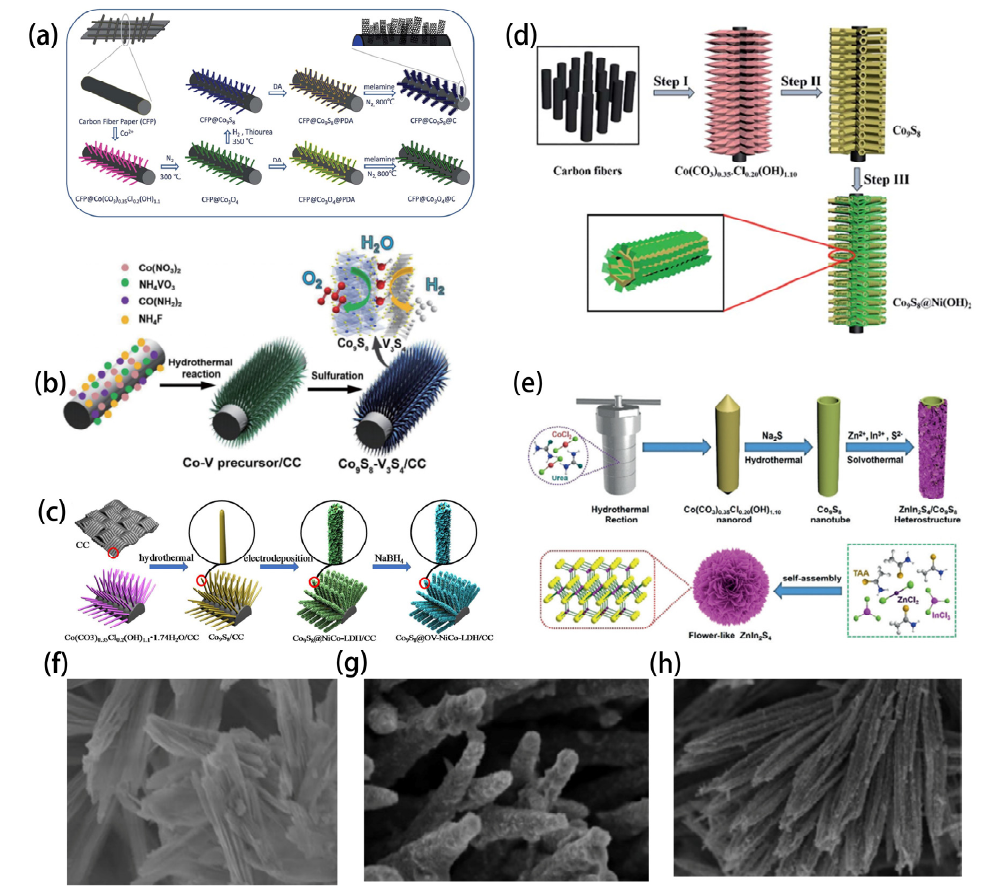
Figure 3. ( a ) The synthetic process for CFP supported Co 9 S 8 @N,S-codoped carbon nanowires with surfaces. Reprinted with permission from Reference [33]. Copyright (2018) Royal Society of